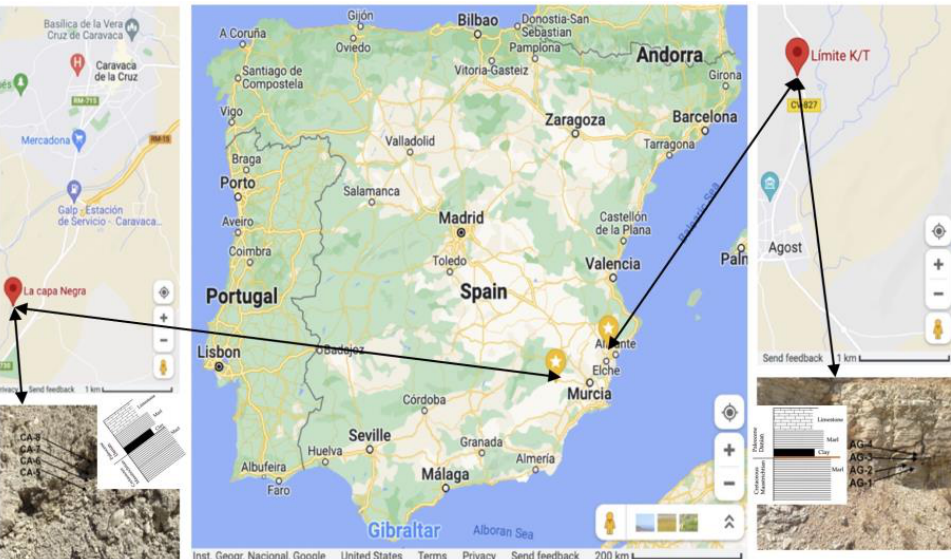
Figure 1. Sample locations in Spain. Samples AG-1, AG-2, AG-3, and AG-4 are collected about 2 km north of Agost ( right ), while samples CA-5, CA-6, CA-7, and CA-8 collected 2 km southwest of Caravaca ( left ). Samples AG-1 and AG-2 were below the dark layer and AG-3 and AG-4 were collected in the dark layer. Samples CA-5 to CA-7 were collected below the dark layer, while CA-8 was collected in the dark layer.